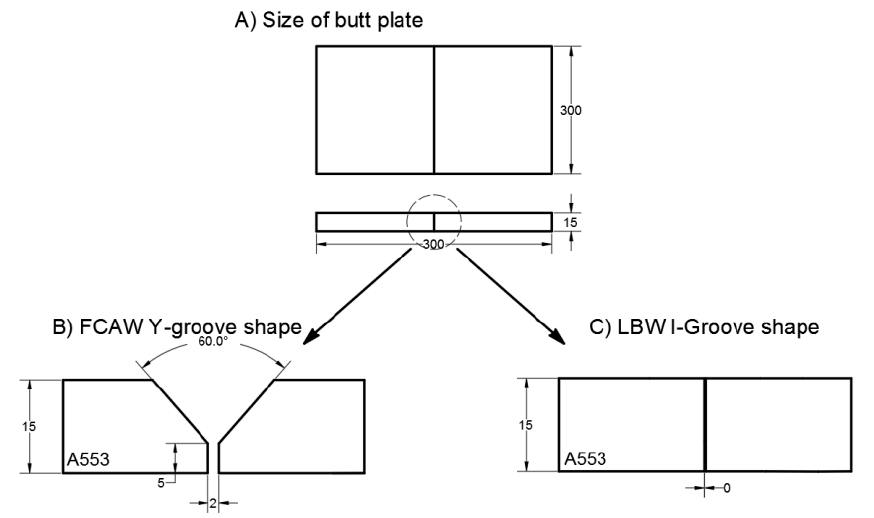
Figure 3. Test specimens and groove shapes.